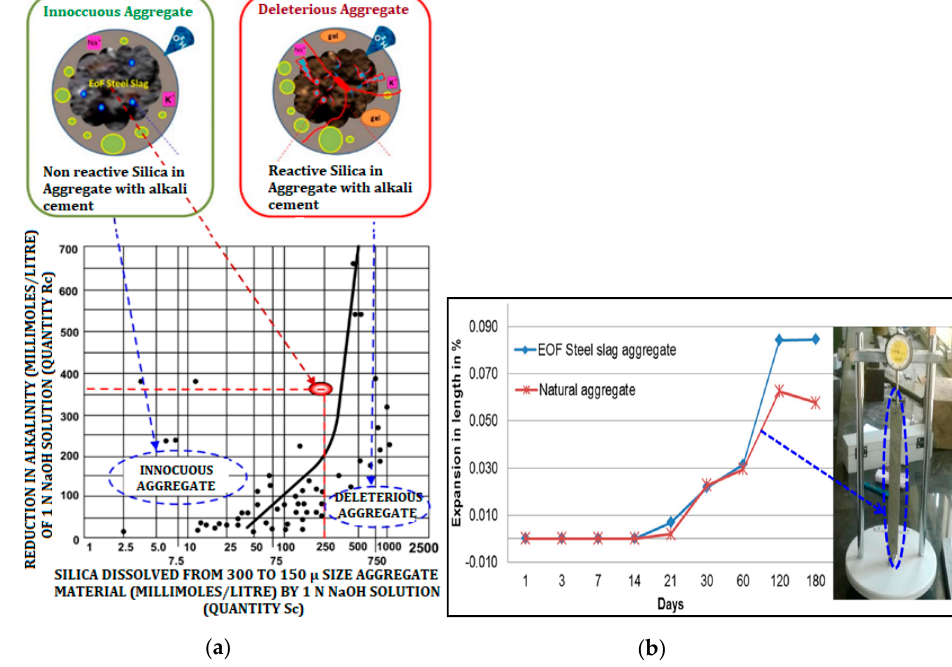
Figure 6. Alkali aggregate reactivity of EOF steel slag ( a ) chemical method with chart (IS: 2386 (part VII)—1963); ( b ) mortar bar method.